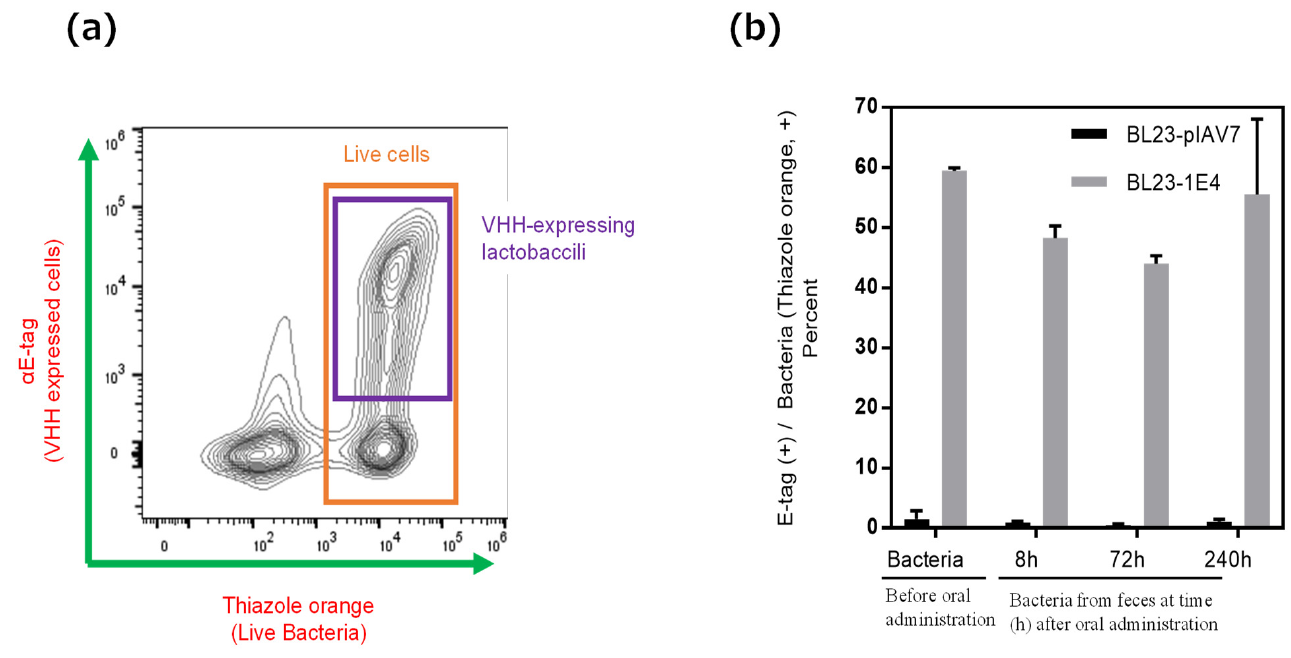
Figure 3. The expression of VHH 1E4 on the surface of lactobacilli collected from the feces of germ-free mice before and after oral administration with strain BL23-1E4. Flow cytometry was used to confirm the display of VHH on the surface of Lactobacillus strains. ( a ) Lactobacilli in the feces of germ-free mice before and after oral administration of L. paracasei BL23-pIAV7 or BL23-1E4 were stained with thiazole orange (TO), whereas 1E4 was detected via E-tag by using rabbit anti-E-tag IgG followed by brilliant violet 421-labelled goat anti-rabbit IgG. The purple box indicates the cell population that is double positive for TO and E-tag-associated 1E4. ( b ) The proportion (%) of E-tag-positive cells among TO-positive cells (i.e., live bacteria) is shown at various times (h) after oral administration of germ-free BALB/c mice with L. paracasei BL23-pIAV7 or BL23-1E4. The experiment was performed three times, and the results are shown as mean ± 1 SD.